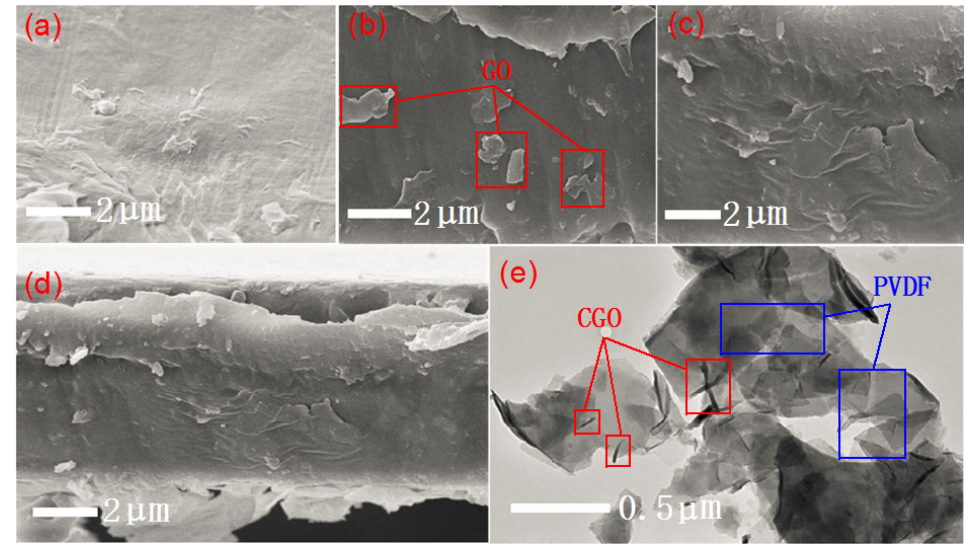
Figure 3. SEM images of ( a ) PVDF, ( b ) GO/PVDF and ( c , d ) CGO/PVDF. ( e ) TEM images of CGO/PVDF.